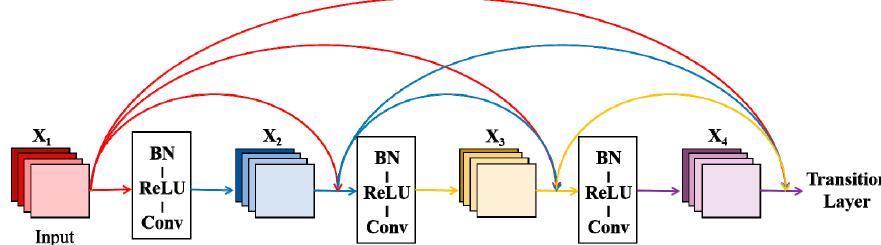
Figure 2. Multi-dimensional Dense Connection Module. (BN refers to Batch Normalization, ReLU refers to Rectified Linear Unit, Conv refers to Convolution.)